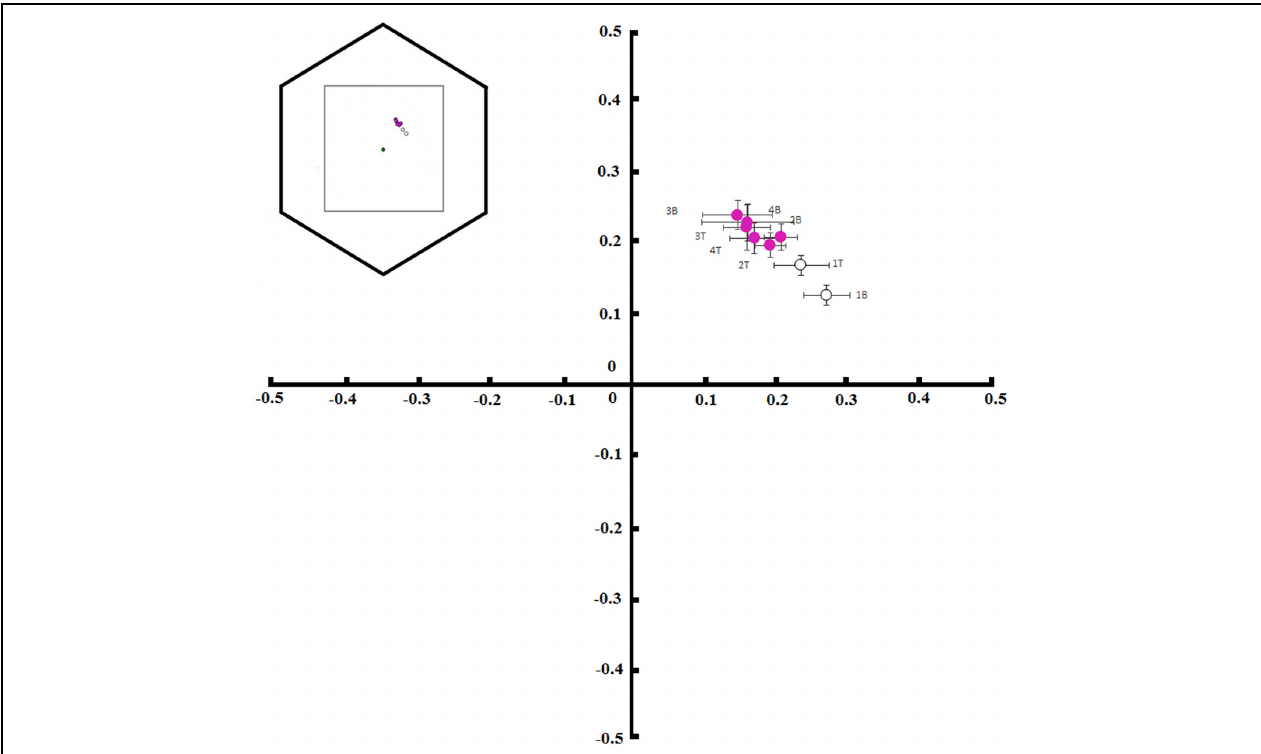
FIGURE 4 | Color hexagon coordinates showing the locus of base (B) and tip (T) colors of petals from T. pulchra flowers. Color measurements were taken on the first (1), second (2), third (3), and fourth (4) days of anthesis (graph model inspired by Suzuki and Ohashi,